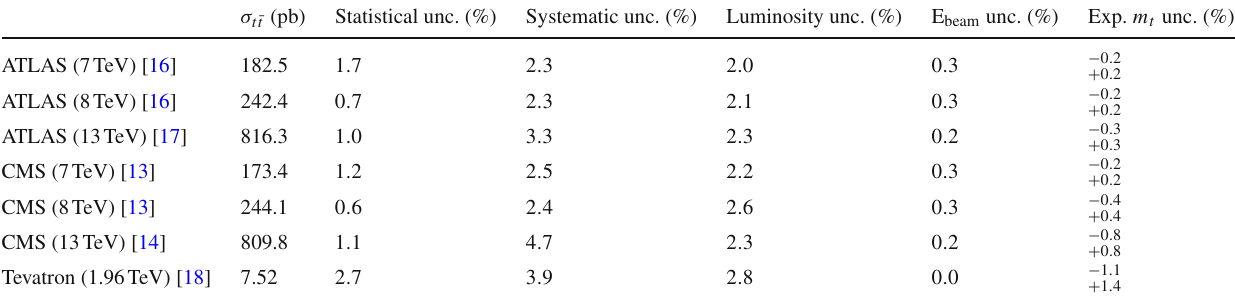
Table 1 Cross sections and experimental uncertainties for the σ t ¯ t inputs that we use [13,14,16–18]. The LHC beam-energy uncertain- ties quoted in these references have been scaled down by a factor 6 . 6 in the light of the recent beam-energy calibration [30], which has a 0.1% uncertainty and coincides with the nominal energy within uncertain- ties. The original beam-energy-induced uncertainties corresponded to 0 . 66% [31]. The Tevatron beam-energy uncertainty is sufficiently small (cf. Ref. [32]) that no beam-energy uncertainty is quoted by CDF and